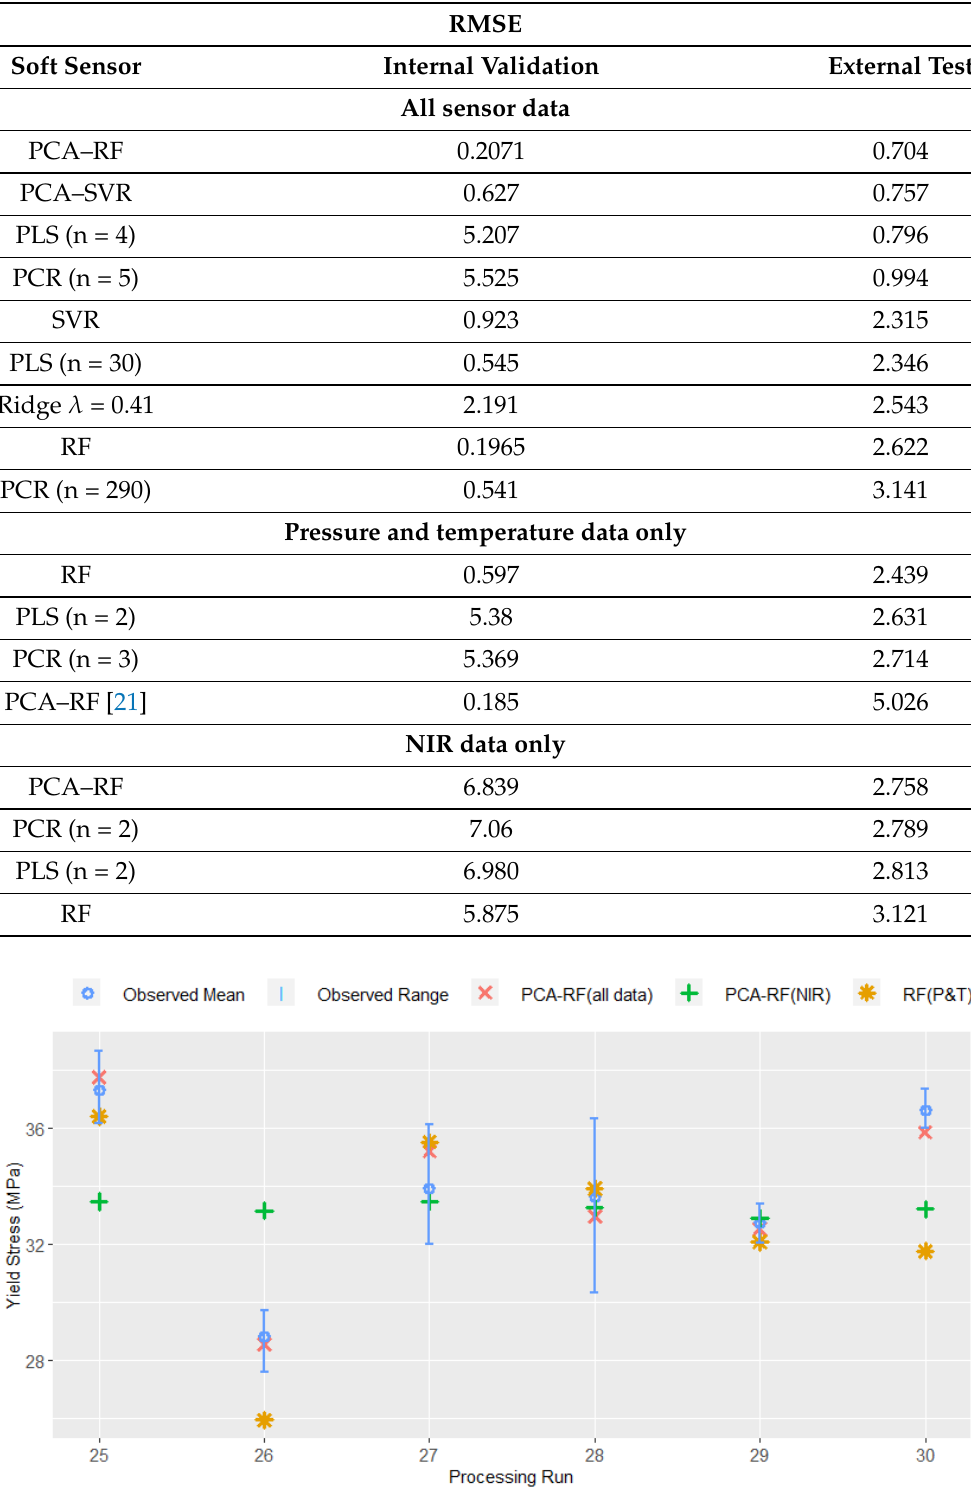
Table 4. Soft-sensor RMSE values.